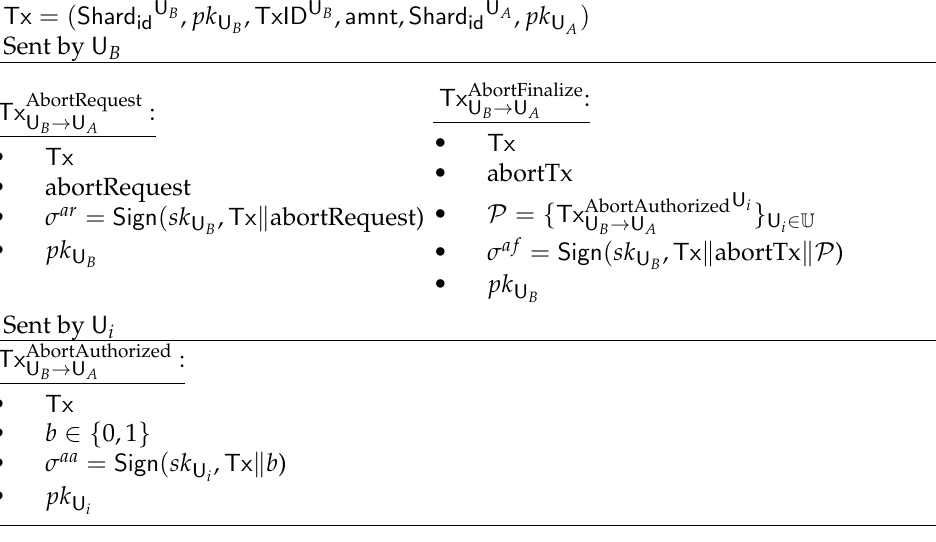
Figure 7. Dandelion abort message description of senders and the network for a valid transaction Tx . We let the bit b = 0 denote denied, and b = 1 denote